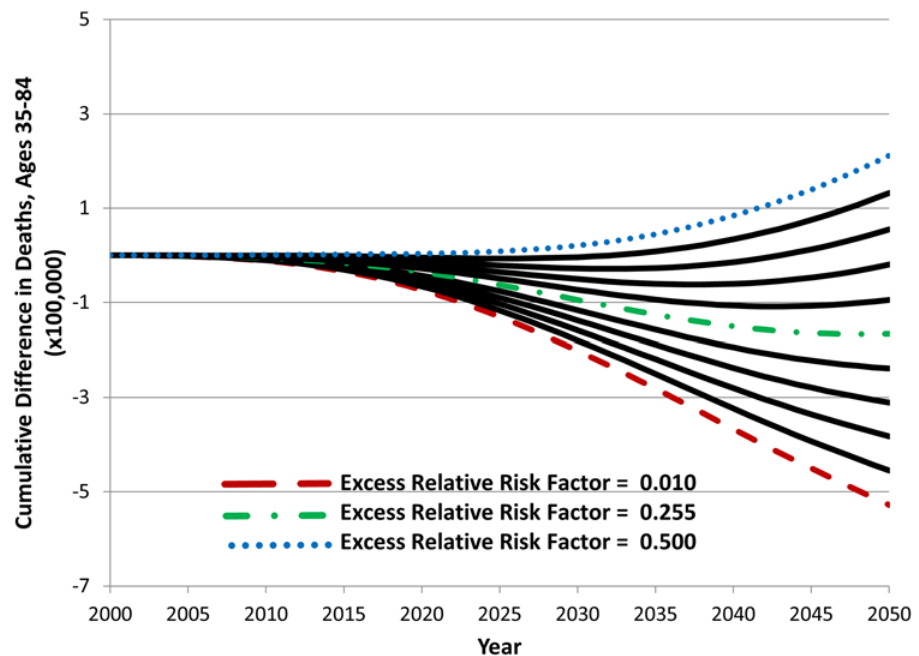
Fig 6. The effect of new product excess relative risk factor values on cumulative difference in deaths between the status quo and hypothetical scenario A, 2000 –